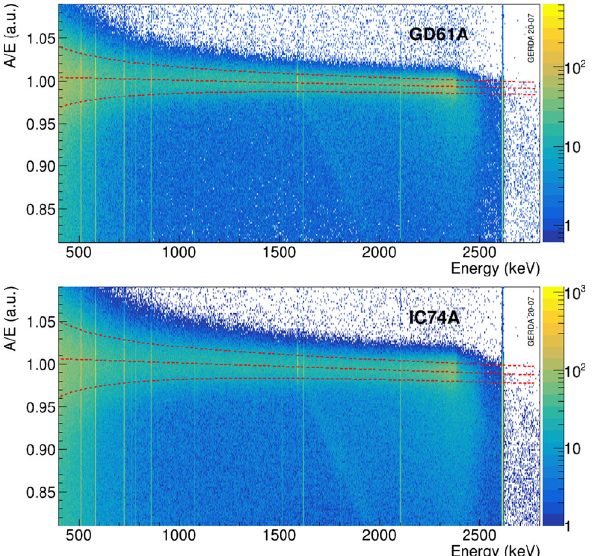
Fig. 5 Distribution of A / E as a function of energy from 228 Th calibra- tiondatafor theBEGedetectorGD61A (top) andtheIC detectorIC74A (bottom). The dashed lines indicate the linear energy dependence and the 1- σ width of SSEs